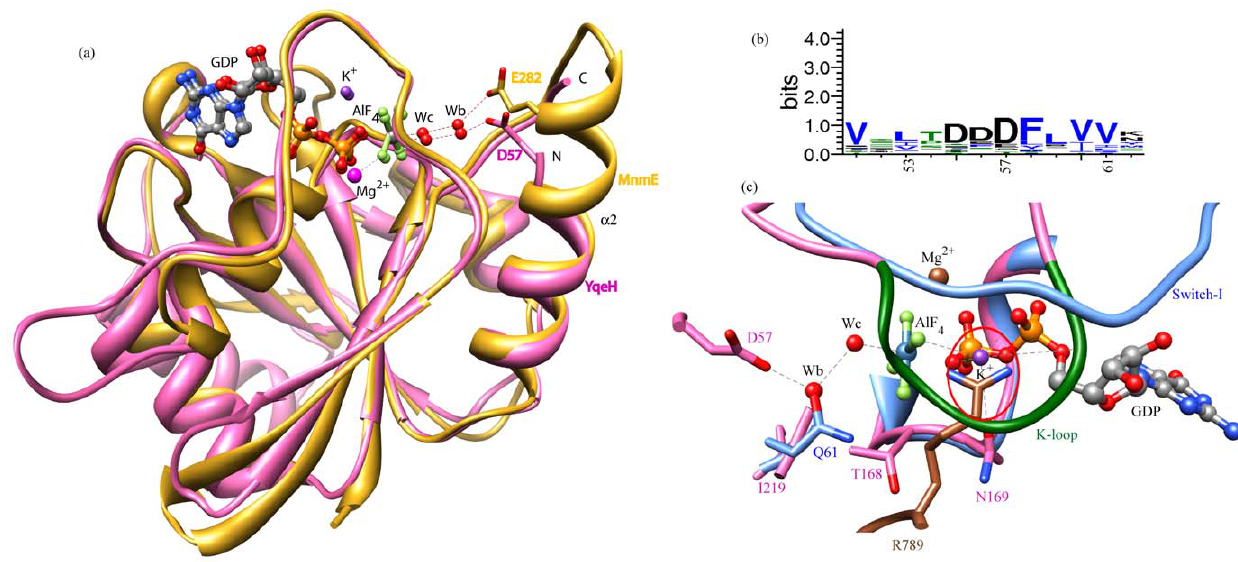
Figure 6. Relocation of the catalytic residue in YqeH. (a) YqeH homology model (pink) and MnmE (gold; PDB: 2gj8) are compared by substrate- based superposition. GDP ? AlF x is shown in ball and stick model. The active site residues are shown as sticks. The nucleophilic water (Wc) and bridging water (Wb) are indicated by red balls. Potassium (K + ) is shown as a violet ball. Magnesium (Mg 2 + ) is shown as a pink ball. Glu-282 in MnmE and Asp-57 in YqeH are indicated. The N and C-termini are shown for YqeH to appreciate the circular permutation. When compared to MnmE, Asp-57 from helix a 2 is relocated to the N-terminus in YqeH due to the permutation. (b) The conservation of residues around Asp-57 at the N-terminal region of YqeH is displayed as a sequence logo [38] and the residue numbers are marked. The alignment of sequences from 26 orthologs that encompasses both bacteria and eukaryotes was made using MUSCLE [35] (c) The active site in YqeH homology model (pink) and Ras (blue; PDB: 1wq1) are compared by substrate-based superposition. Switch-I and K-loop (in green) are indicated. Arg-finger (Arg-789) from Ras-GAP is represented as stick model in brown. Magnesium (Mg 2 + ) is shown as a pink ball. GDP ? AlF x is shown in ball and stick model. The active site residues are shown as sticks. The water mediated interaction from Asp-57 to catalytic water (Wc) is shown by a dotted gray line. The relative position of bridge water (Wb) coincides with that of the amide oxygen in Gln-61 of Ras. In contrast to Gln-61 in Ras, the corresponding position in YqeH is occupied by hydrophobic I219, which is retracted away from the catalytic site. The location of potassium overlaps with the position of Arg-finger (R789) in Ras-GAP and it is highlighted by a red circle. It may be seen that the presence of K-loop sterically occludes the approach of an Arg-finger like residue in YqeH.